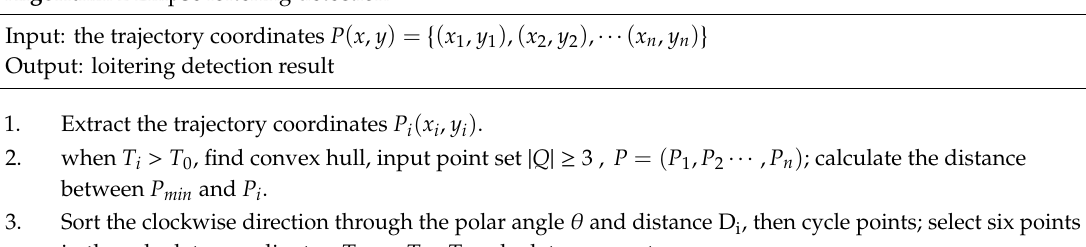
Algorithm 2 Ellipse loitering